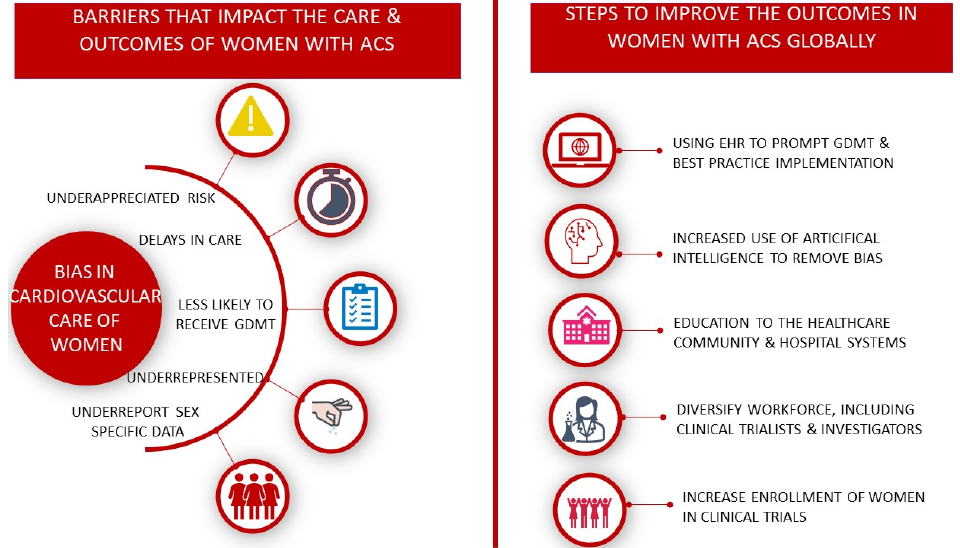
Figure 2. Bias in the care of women with acute coronary syndromes and actionable items to improve outcomes. Guideline Directed medical therapy (GDMT).